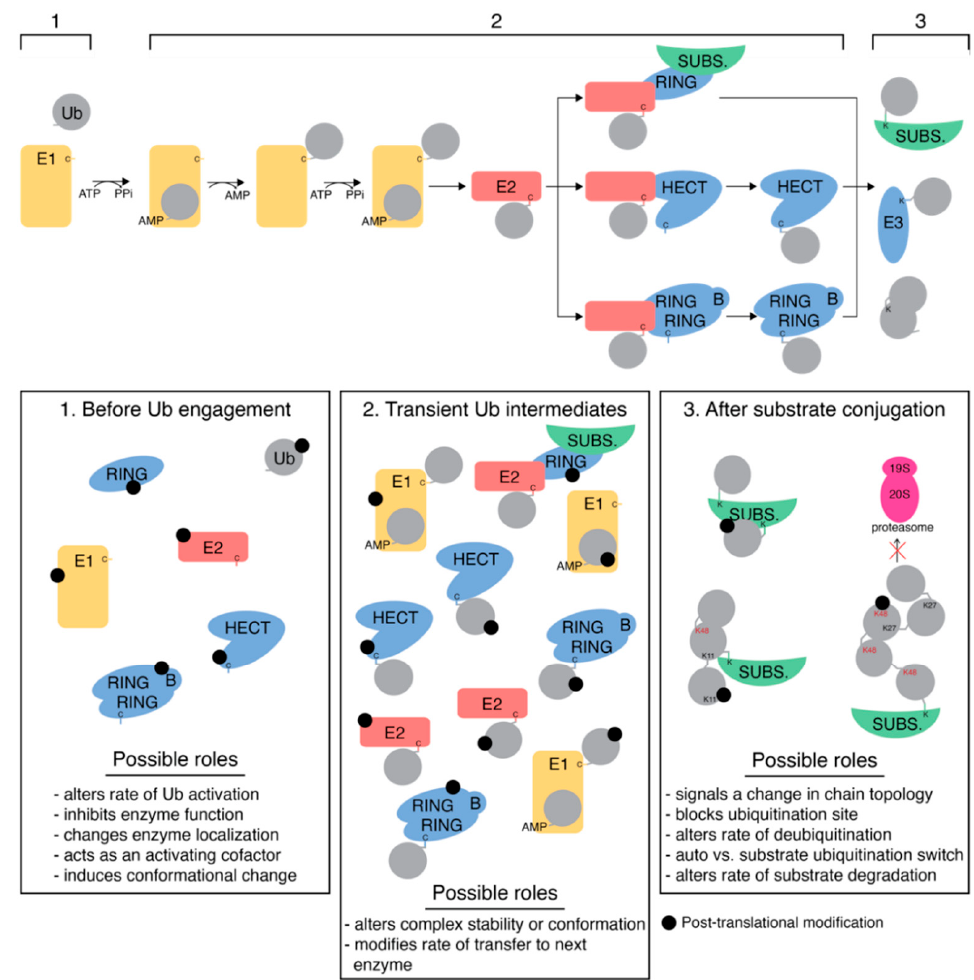
Figure 4. Implications of post-translational modification of ubiquitination proteins. The ubiquitina- tion pathway for RING, HECT, and RBR E3 ligases is shown at the top. Post-translational modification of these proteins can occur at three points in the ubiquitination cycle: (1) before Ub engagement, (2) contained in a transient Ub complex, or (3) after substrate conjugation. Thioester intermediates are indicated by ‘C’ (cysteine), while stable isopeptide linkages are denoted by ‘K’ (lysine). Potential roles of PTMs at each point in the cascade are listed.